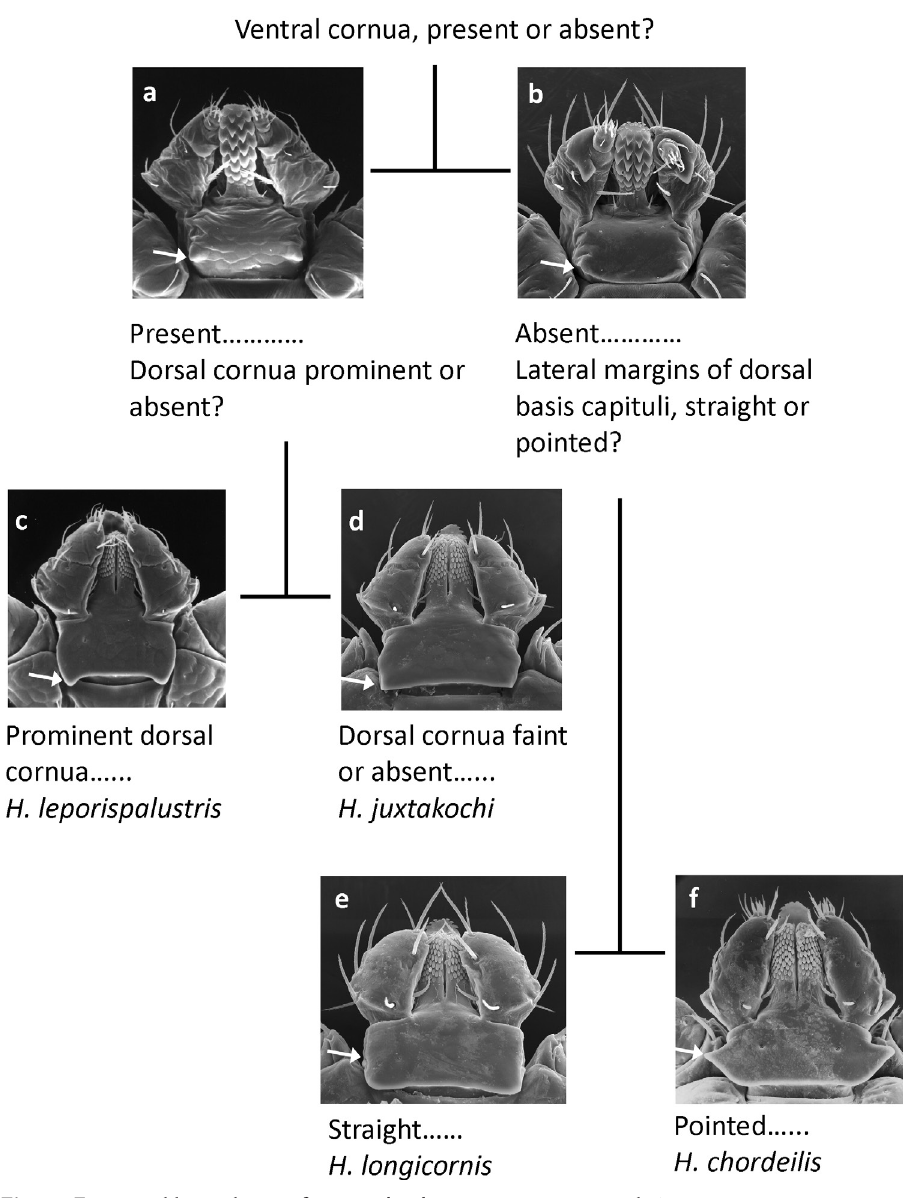
Figure 7. Pictorial key to larvae of Haemaphysalis spp. occurring in North